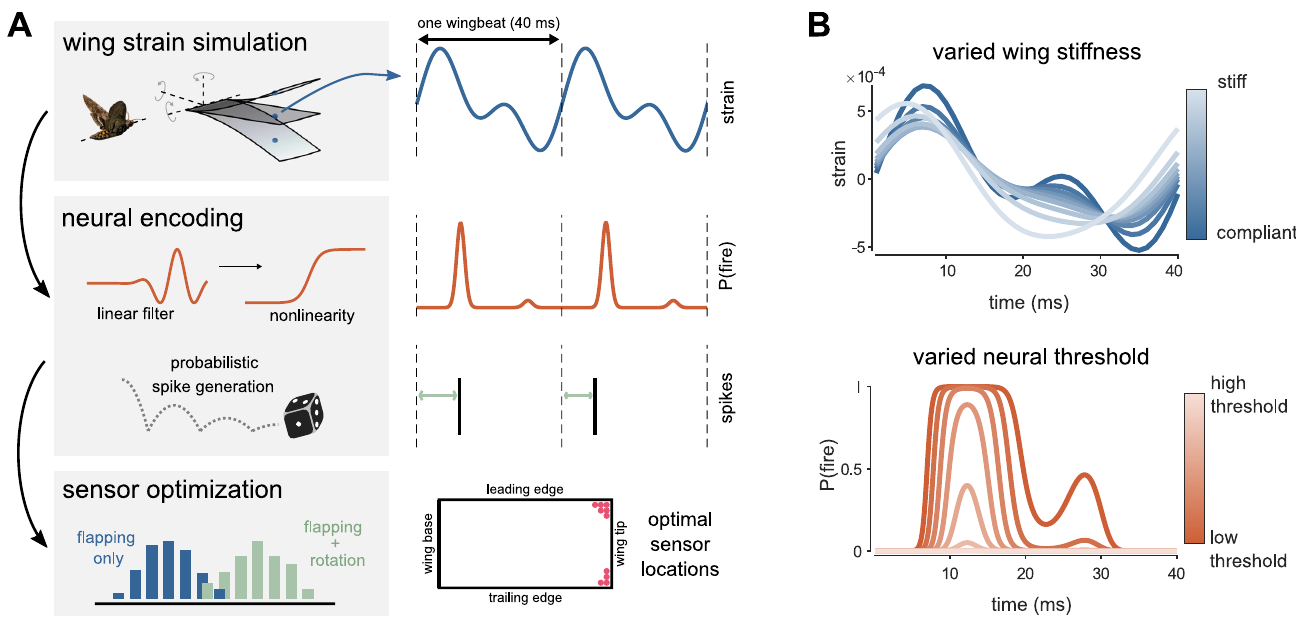
Fig 1. Wing stiffness and neural encoding properties determine optimal sensor locations on a flapping wing. A: Top : Strain over time is simulated at each possible sensor location in an Euler-Lagrange model of a flapping wing [23, 31]. The wing may be subject to rotation in different axes. Strain is shown for an example sensor location (blue dot). Middle : Strain at each location is encoded by a neural-inspired sensor. Strain is convolved with a linear filter and passed through a static nonlinearity to generate a probability of firing a spike over time, P(fire). Spikes are probabilistically generated, so that exact spike time varies from wingbeat to wingbeat. Bottom : The full data set, a matrix of spike times at all sensor locations for each wingbeat, is used to find a subset of sensors from which information about rotation can be read out. Linear discriminant analysis is used to find the vector w , such that when the data are projected onto w the means of the flapping only and flapping with rotation data are maximally separated. B: Top : Changing wing stiffness produces different strain (shown for identical location) over the course of each wingbeat. Bottom : Changing the threshold of the neural encoding nonlinearity alters of the probability of firing over the course of the wingbeat, with higher thresholds resulting in lower probability. Hawkmoth image in A courtesy of Armin J Hinterwirth.